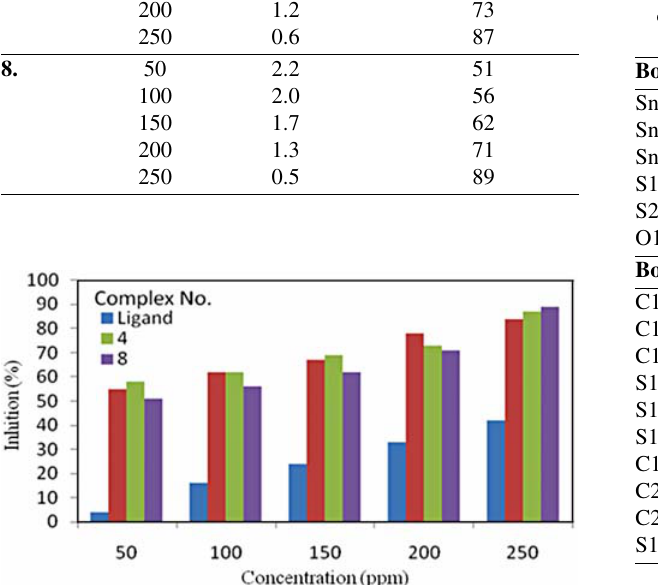
Figure 3. ORTEP view of the complex [ ( n -Bu) ( 8 ) with displacement ellipsoids drawn at 40% probability